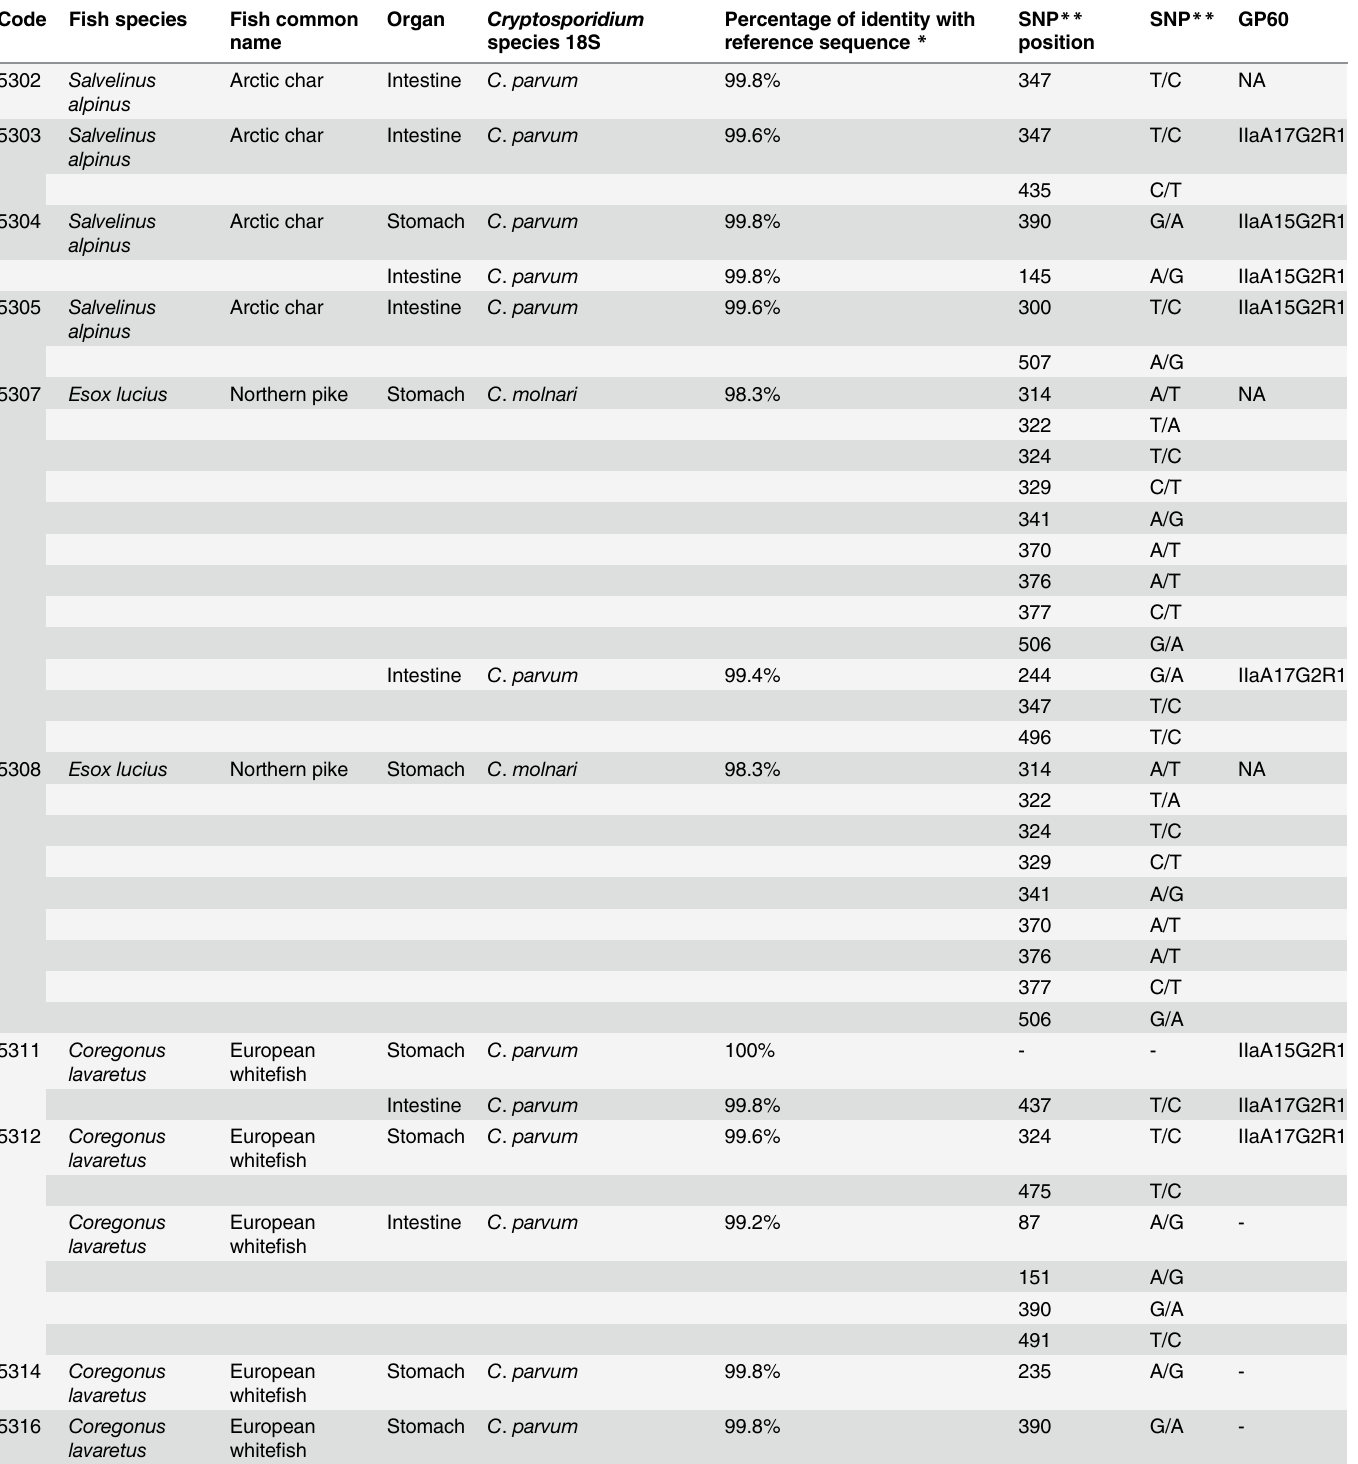
Table 2. Cryptosporidium species and subtypes in wild freshwater fish from Lake Geneva identified at the 18S rDNA and GP60 loci. Code Fish